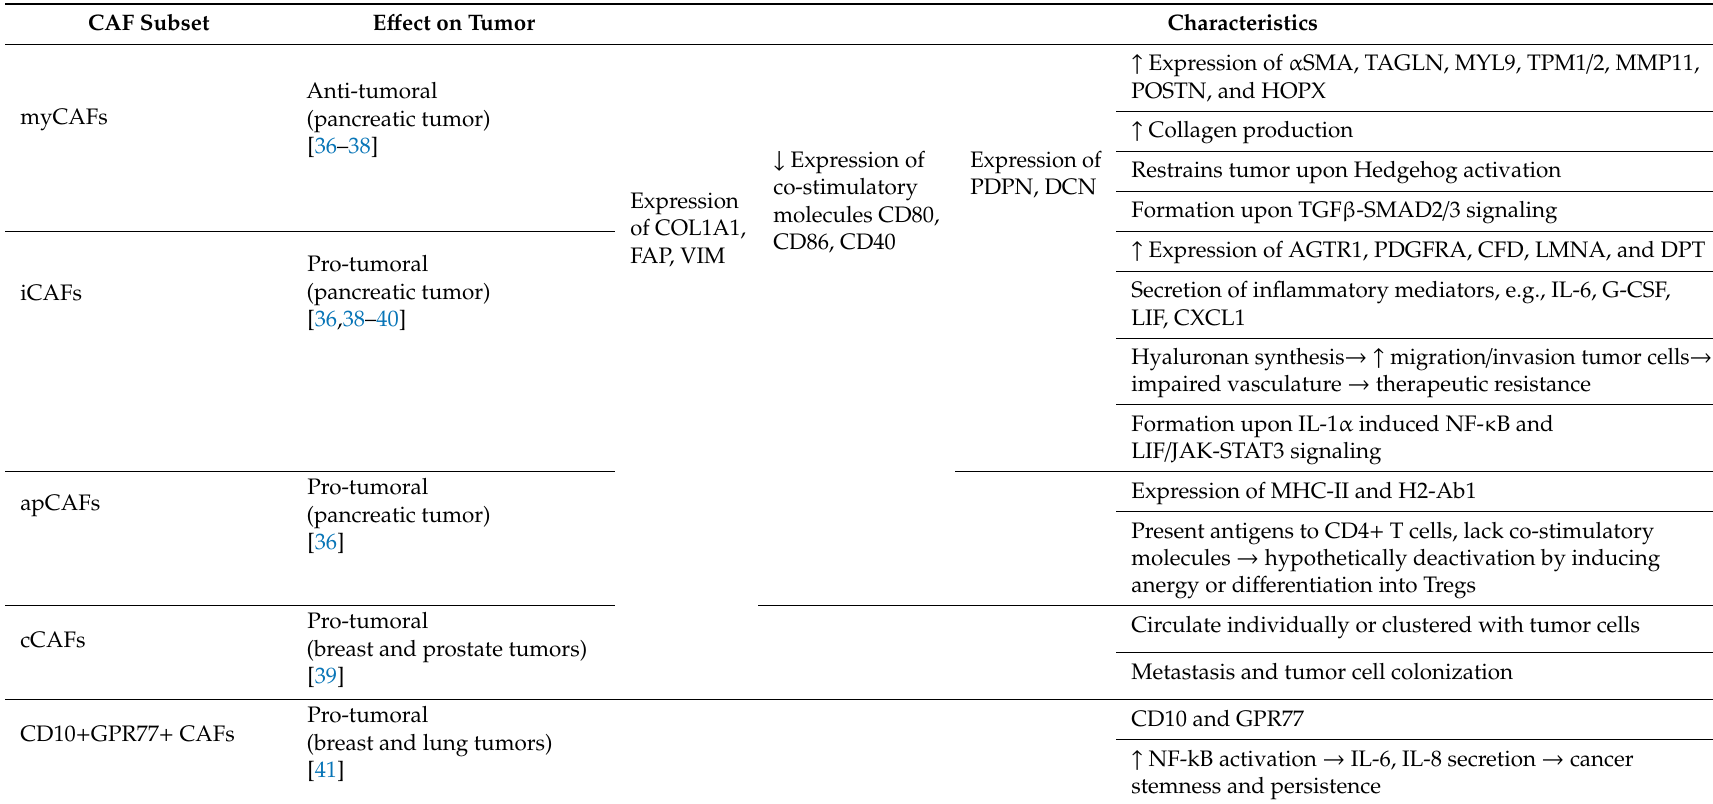
Table 1. Characteristics and functions of five distinctive CAF